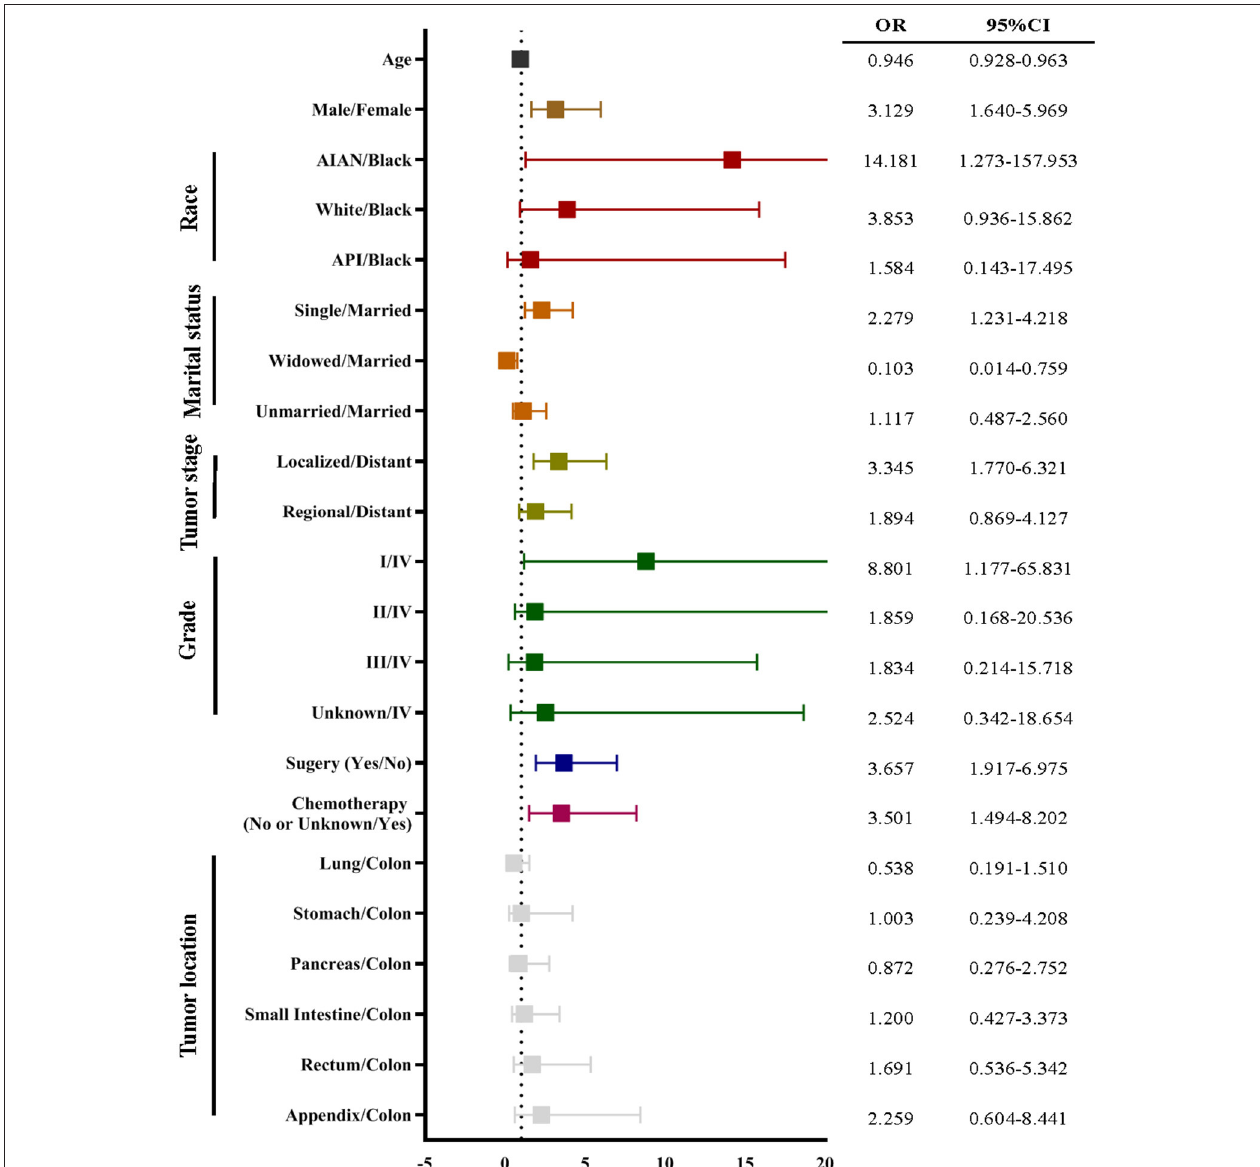
FIGURE 3 | The univariate logistic regression of suicide using the training data set. The univariate logistic regression demonstrated that age, gender, race, marital status, cancer stage, cancer grade, surgery, and chemotherapy were associated with suicide of neuroendocrine neoplasm (NEN). The odds ratio (OR) was presented by a square, and the 95% confidence interval (CI) was presented by the horizontal lines with